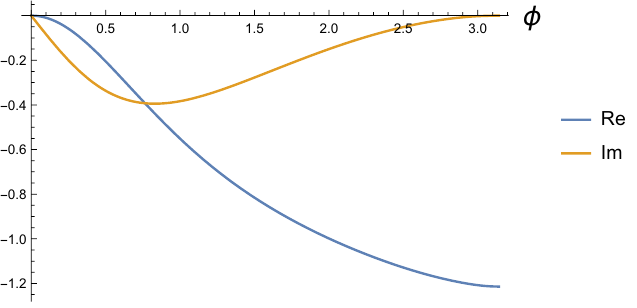
Figure 5 . The real and imaginary parts of the two particle form factor for the masses m 1 = 1 and m 2 = p 3 and the value of the trilinear coupling (5.21). The plot is constructed with N max = 50.